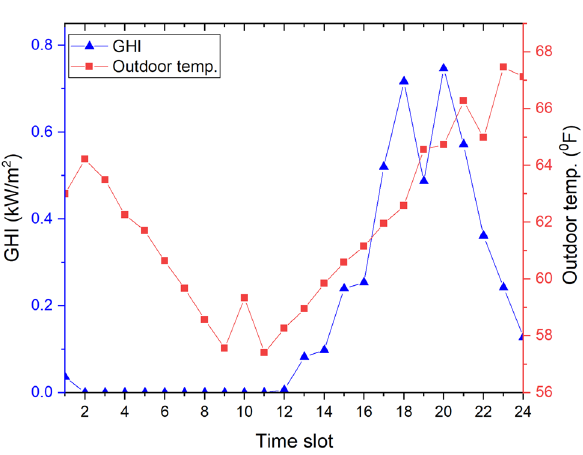
Figure 4. Day-ahead GHI and outside temperature of day in Detroit city.